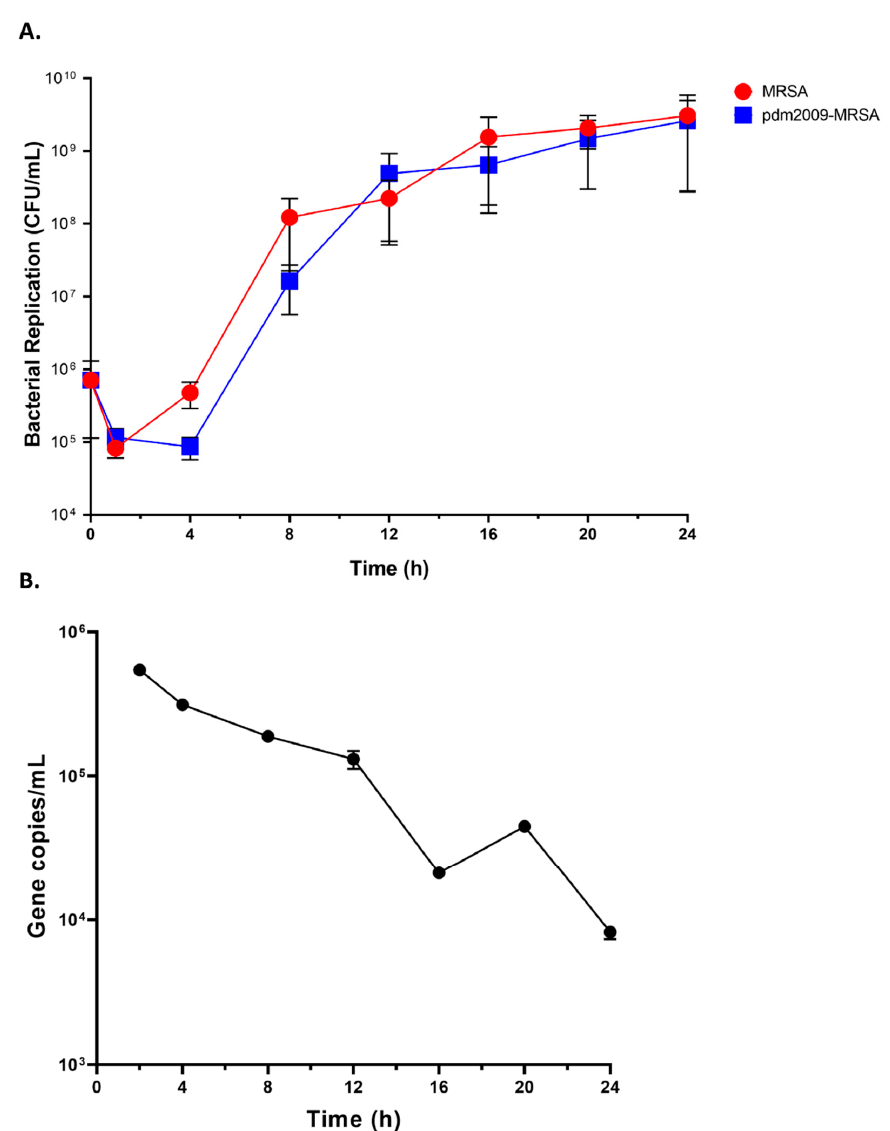
Figure 1. Pathogen replication kinetics during bacterial infection and influenza-bacterial